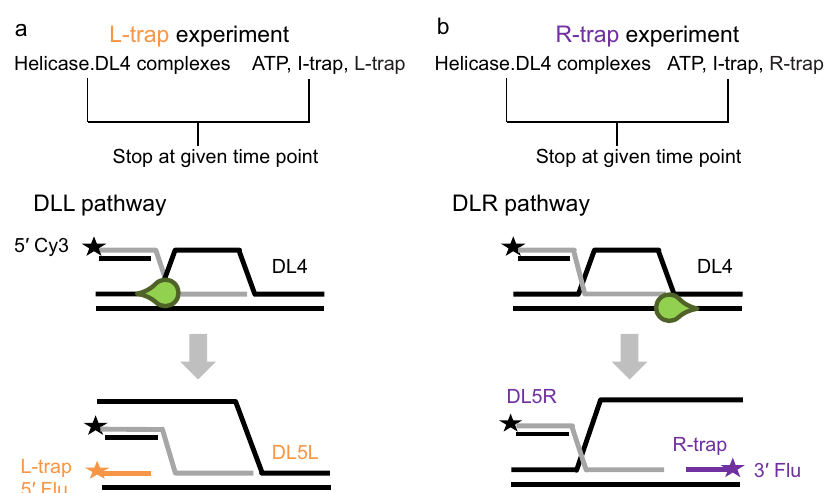
Fig. 5 Schematic representation of L-trap and R-trap experiments to dissect and quantify all conceivable D-loop processing pathways. a , b Mixing fl uorescein-labeled ssDNA trap strand ( a , L-trap (orange) or b , R-trap (purple)) along with the I-trap and ATP with the helicase (green drop) — DL4 complexes (gray invading strand; black star: Cy3 label) during D-loop processing experiments allows resolution of the previously unobservable unwinding of the dsDNA “ arms ” of the D-loop structure (see also the orientations labeled with purple dots in the DLN pathway shown in Fig. 3) in addition to previously observable pathways (Fig. 3). In L-trap experiments, unwinding of the dsDNA arm upstream of the invasion will lead to the formation of the fi ve- stranded double-labeled DL5L structure, whereas in R-trap experiments, the unwinding of the dsDNA downstream of the invasion will lead to the formation of the fi ve-stranded double-labeled DL5R structure, due to the complementary binding sites for the labeled trap strands. DNA sequences are described in